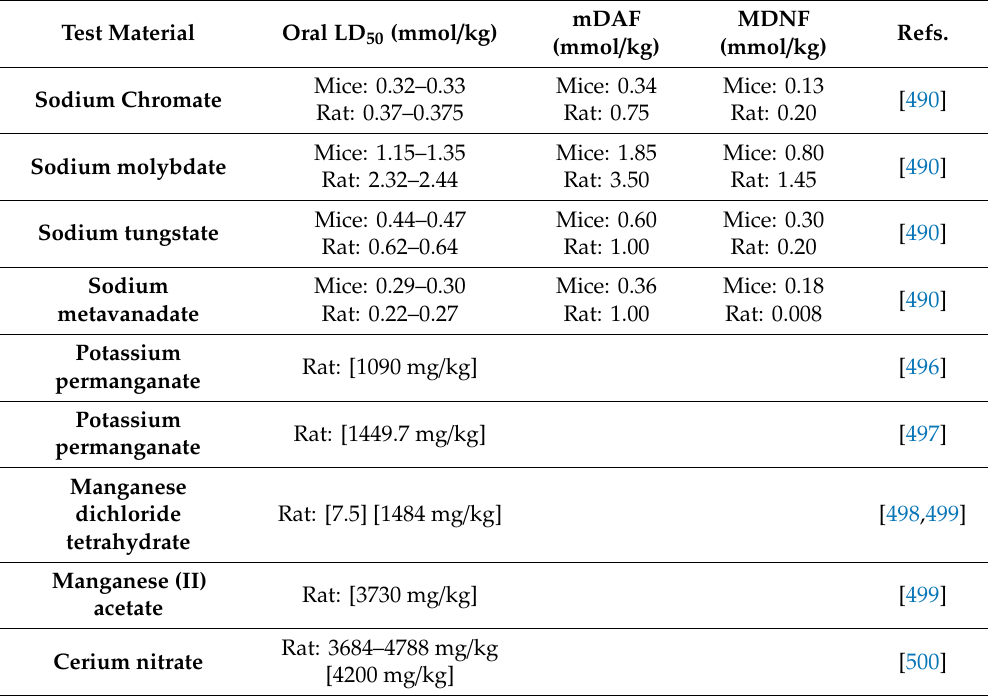
Table 7. Toxicity data for chemistries of plausible sealing